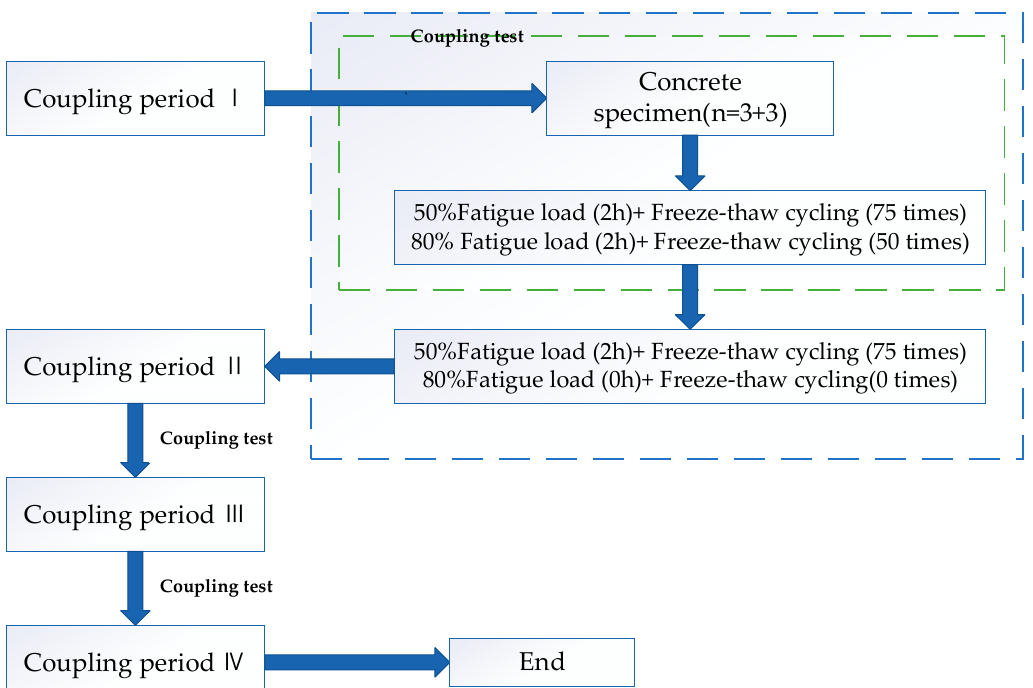
Figure 2. Flow chart of the double ‐ field coupling experiment [30].